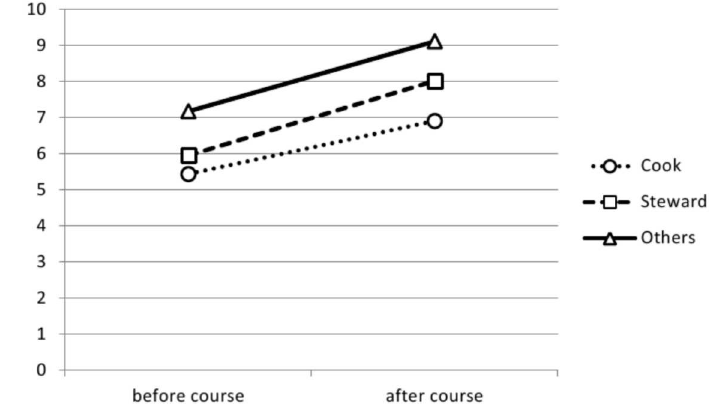
Figure 6. Mean values of the level of participant knowledge concerning children’s eating behaviors before and after the course, according to professional